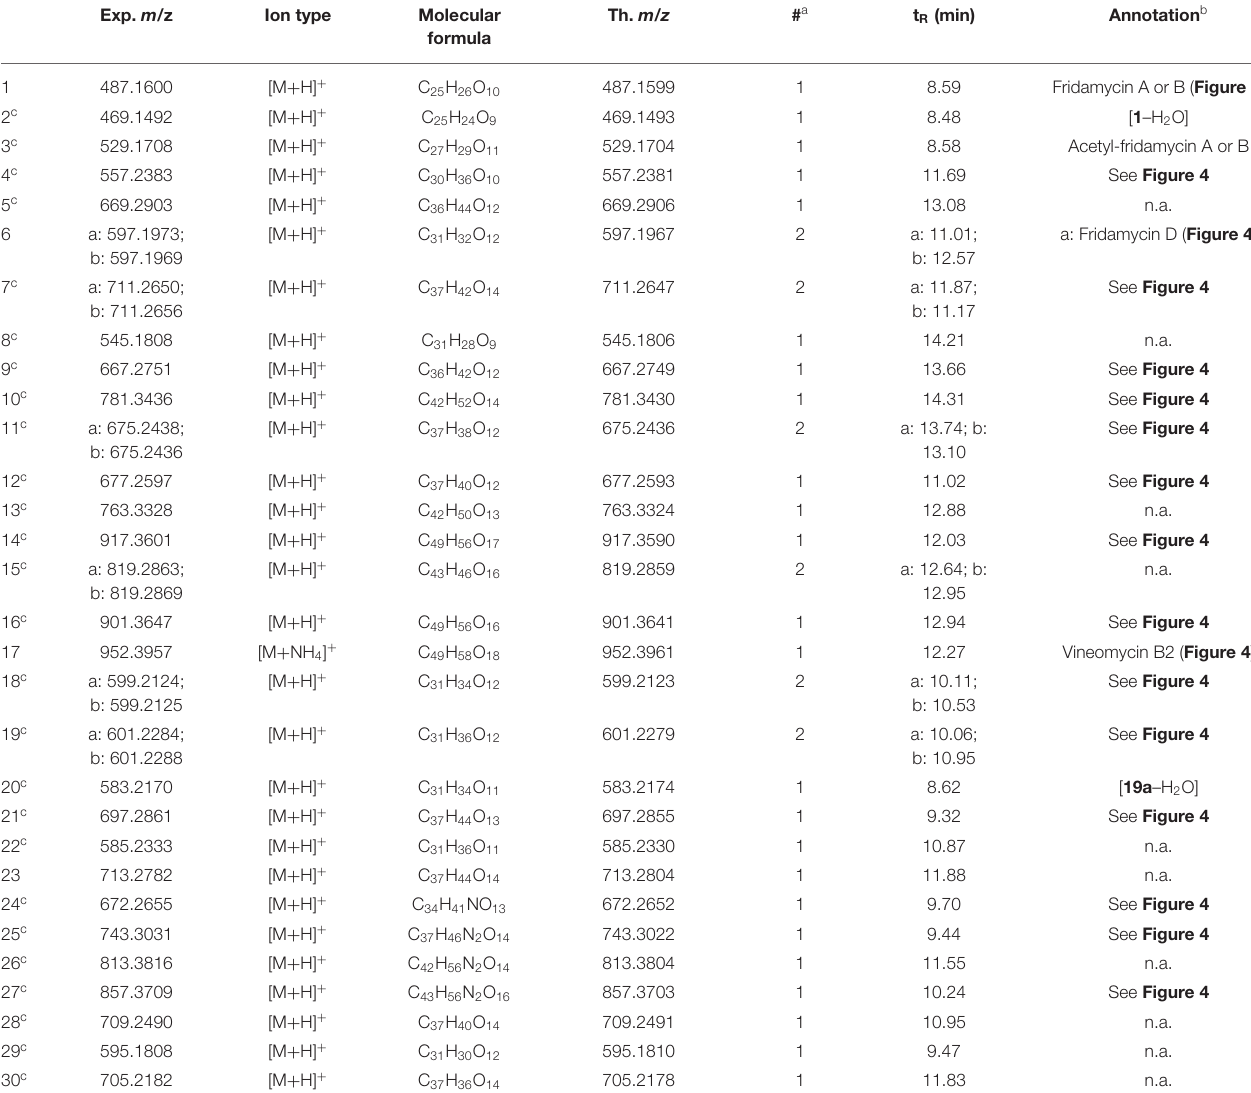
TABLE 1 | Annotated angucyclines in the metabolomic profile of strain RO-S4. Exp. m/